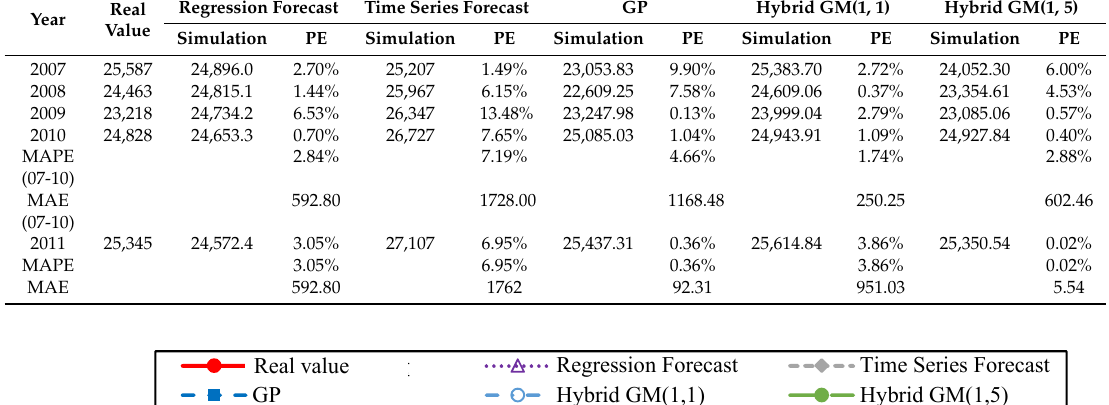
Table 9. Comprehensive comparison of forecast model trained with the data from 2007–2010 and tested with the data in 2011.